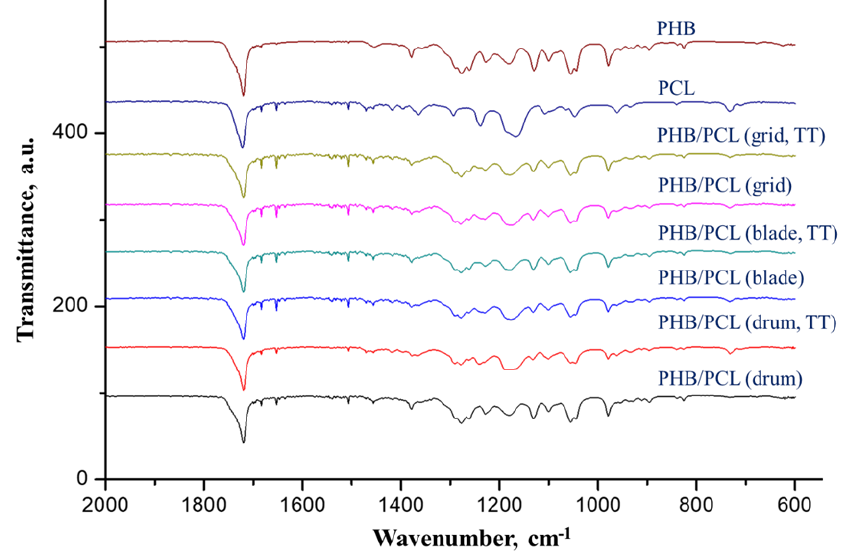
Figure 6. FTIR-ATR spectra of the PHB / PCL mats prepared onto rotating drum, blade and grid collectors before and after thermal treatment (TT).